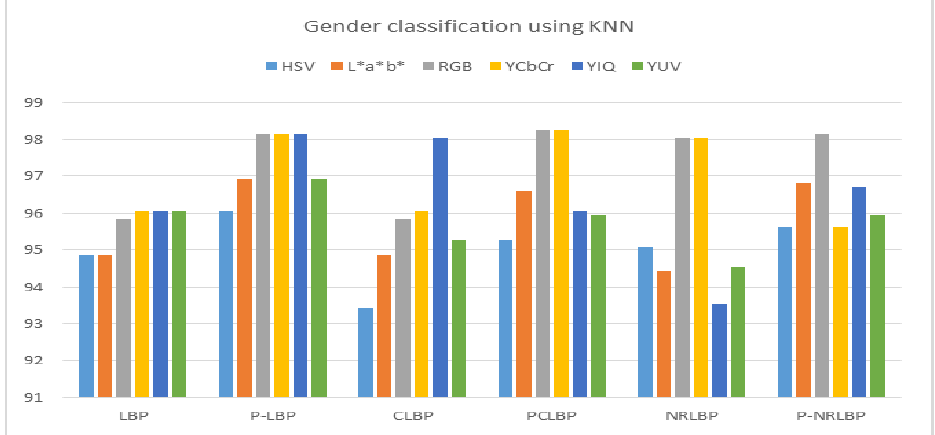
Figure 8. Gender classification using KNN (PICS database).